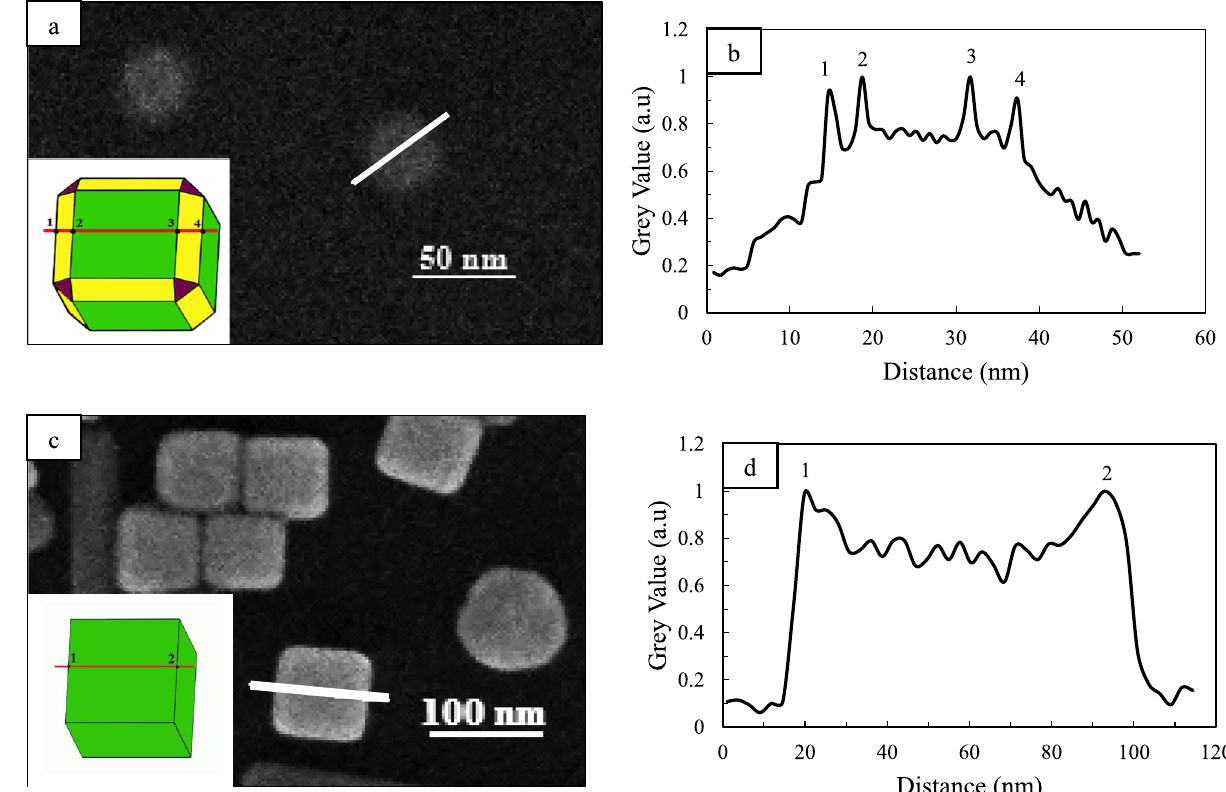
Figure 4. High-magnification SEM images of Ag nanocubes obtained in dark condition at 15 min ( a ), and in the presence of 200-W incandescent lamp ( c ). The insets are the scheme of Ag nanocubes obtained in different conditions. ( b , d ) grey value intensity along the white line in ( a , c ) respectively, the intensity of the edges are very different from the background noise and flat points thus edges on the line can be identified.